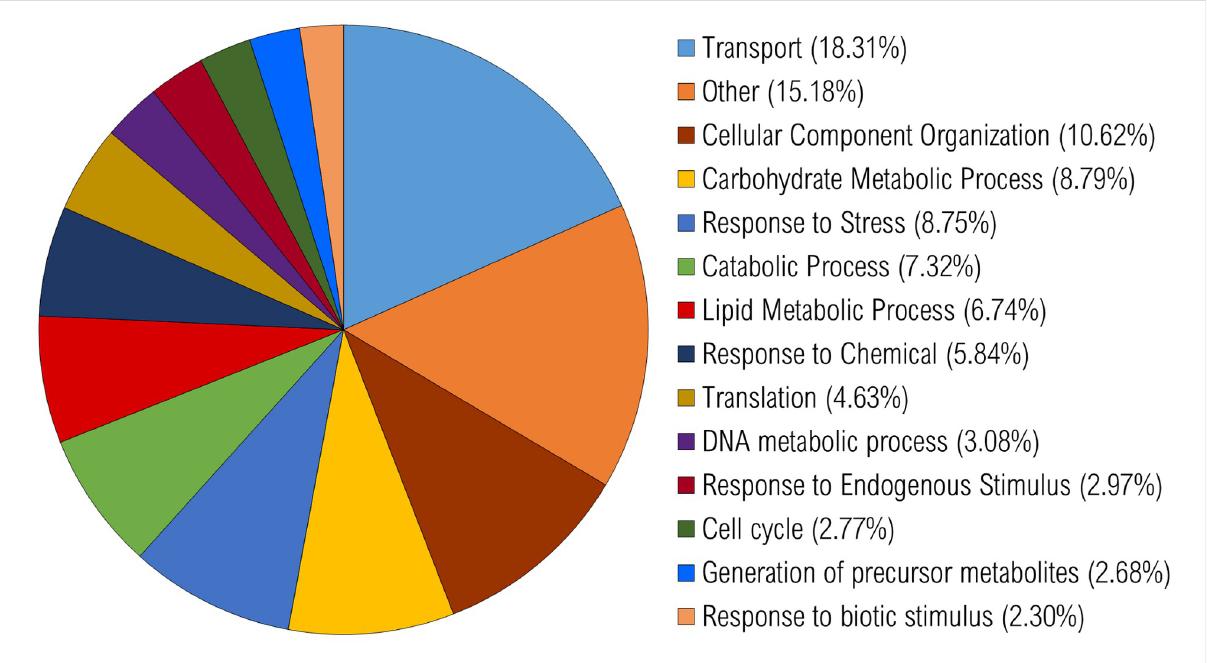
PLOS ONE | https://doi.org/10.1371/journal.pone.0274740 October 13,